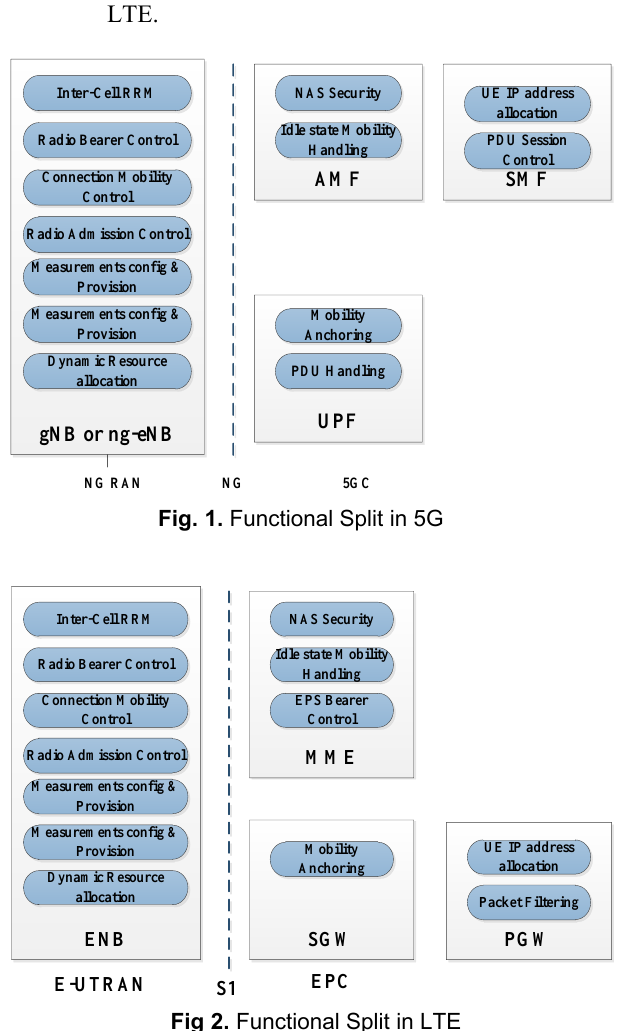
Fig 2. Functional Split in